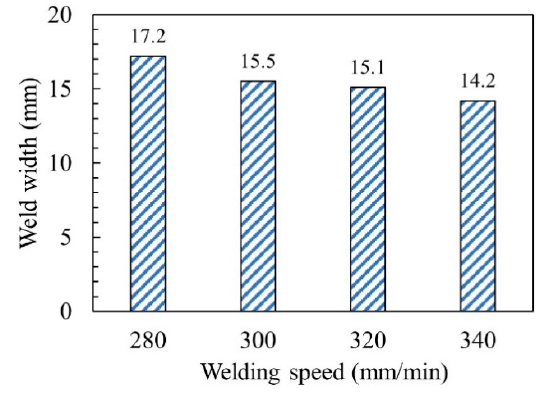
Figure 4. Weld width at different welding speeds.